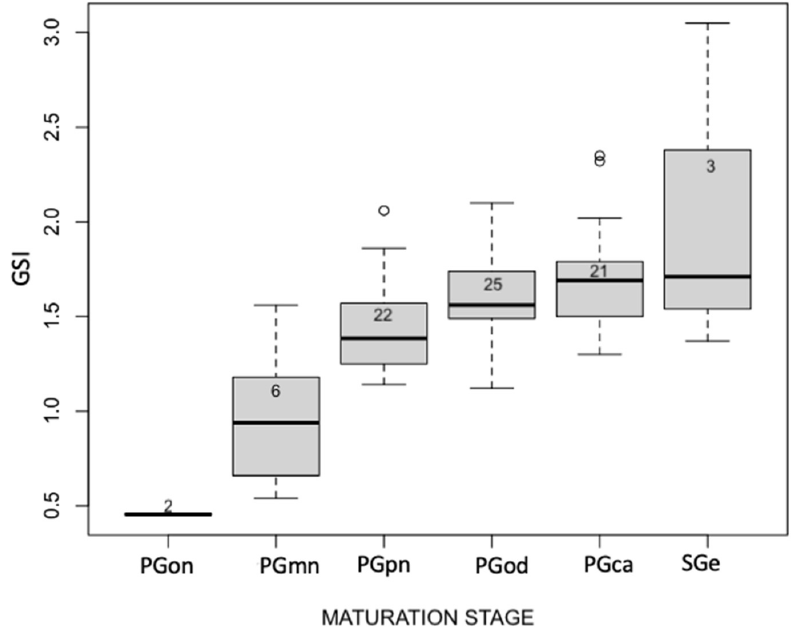
Figure 5. Boxplot shows the relation between the oocyte maturation stage and the GSI values of sampled eels.